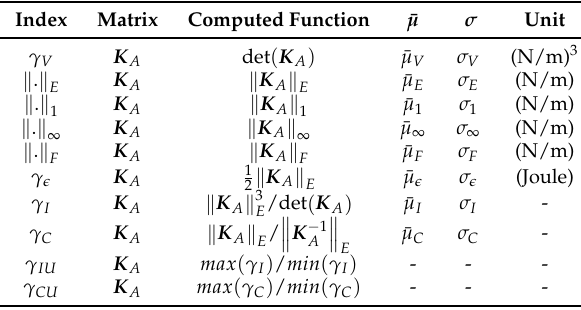
Table 1. Utilized stiffness performance